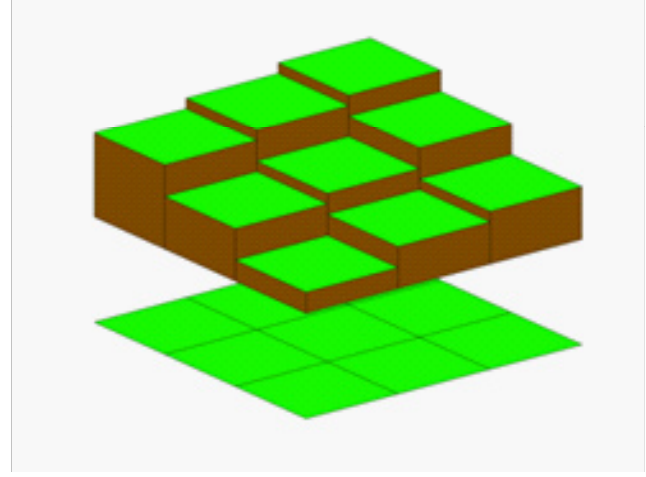
Figure 1. Sample digital elevation model (figure drawn according to Jenness